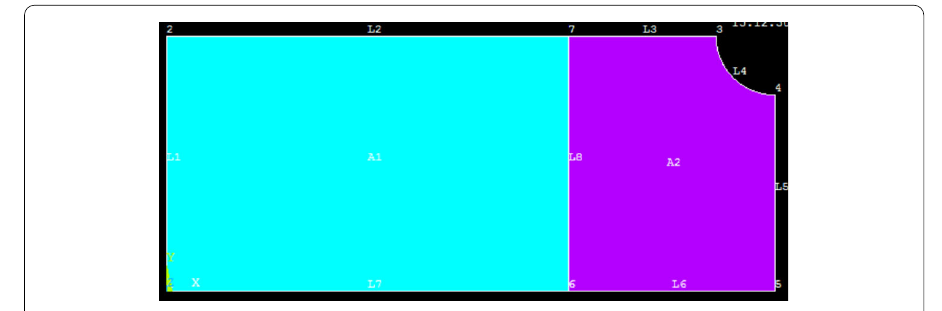
-Model with symmetry). Model and mesh of the notched plate 4